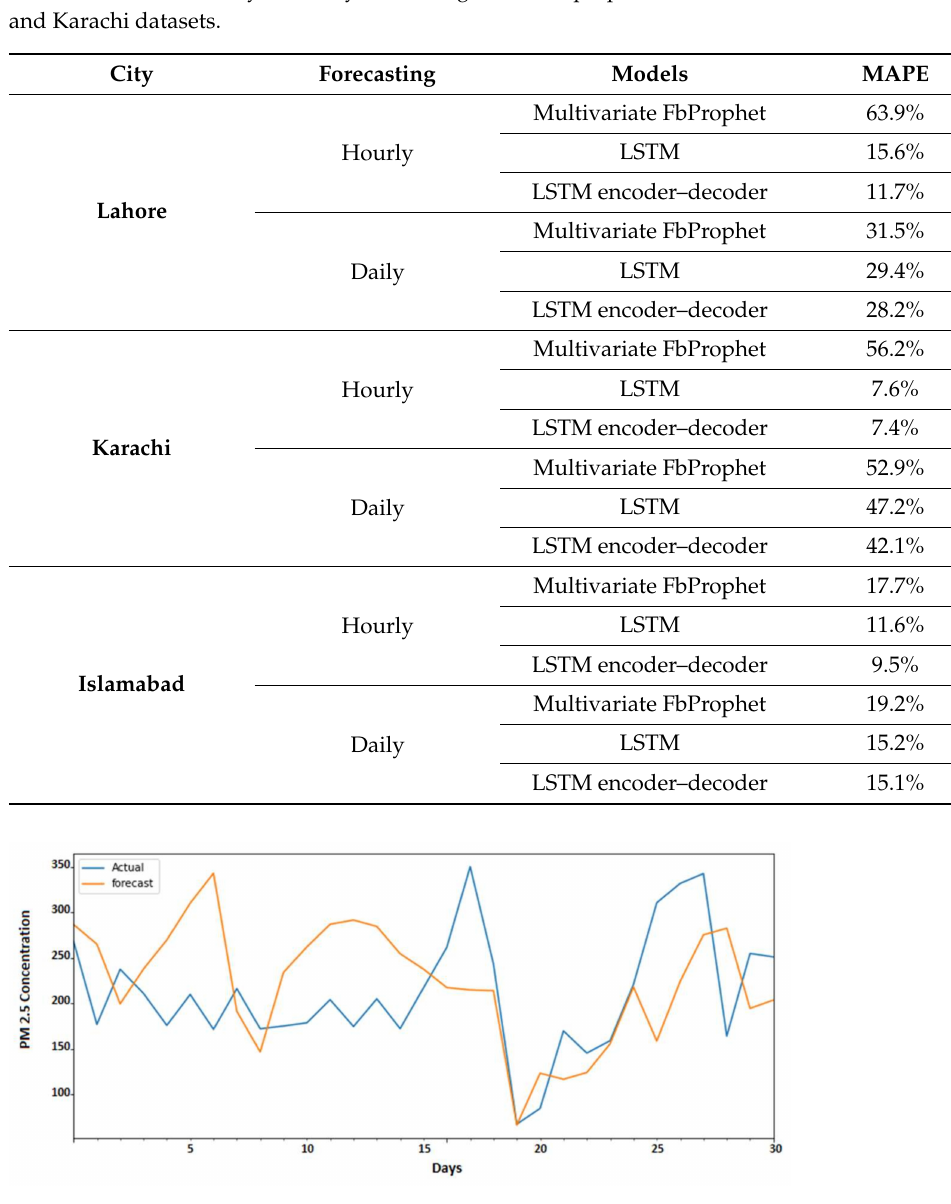
Figure 8. Forecasting for the next month for Lahore using the multivariate FbProphet